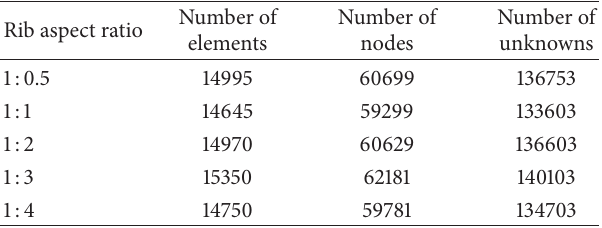
Table 1: Data of the computational meshes shown in Figure